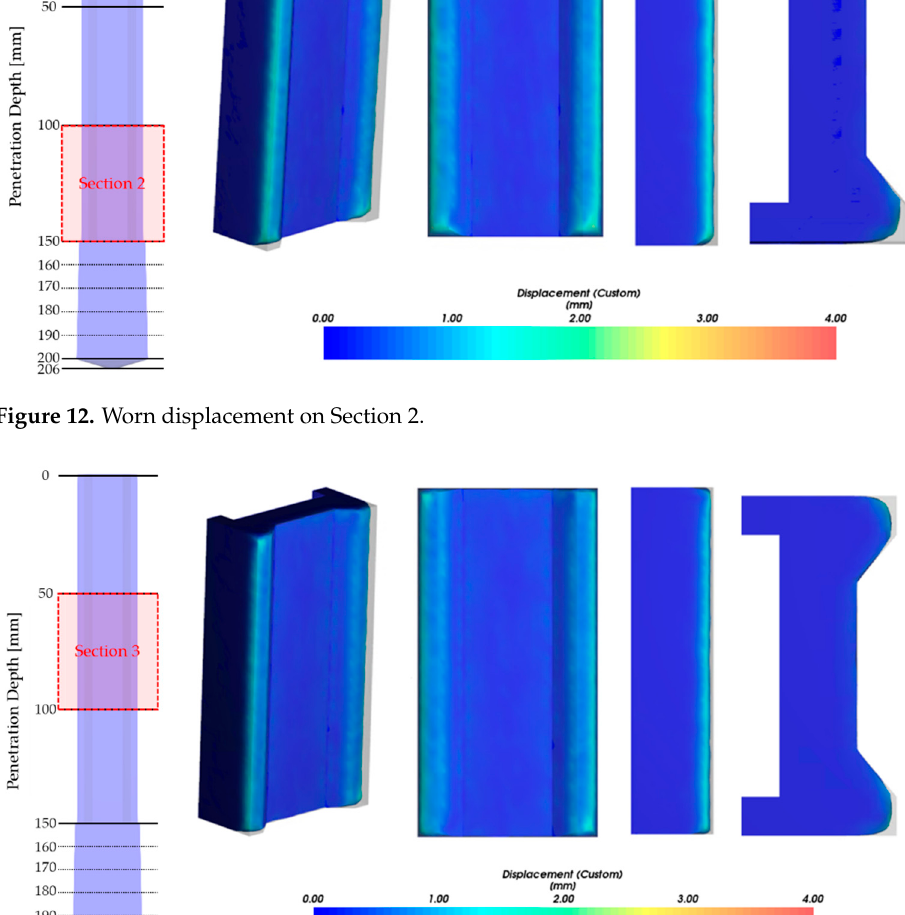
Figure 13. Worn displacement on Section 3.